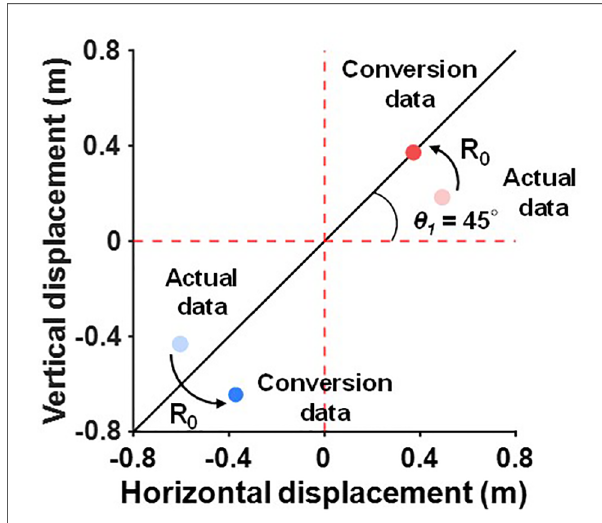
FIGURE 2 De fi nition of the relative deviation of breaking balls from the four-seam fastballs. The relative deviation of breaking balls is calculated by the following procedure. First, obtain the rotation matrix (R 0 ), which transforms θ 1 to 45° in the horizontal and vertical displacement plane. Then, apply the rotation matrix (R 0 ) to the deviation of the curveballs and sliders. The transparent red and blue dots indicate the deviation of the four-seam fastball and curveball for actual data. The fi lled red and blue dots indicate the deviation of the four-seam fastball and curveball after conversion.